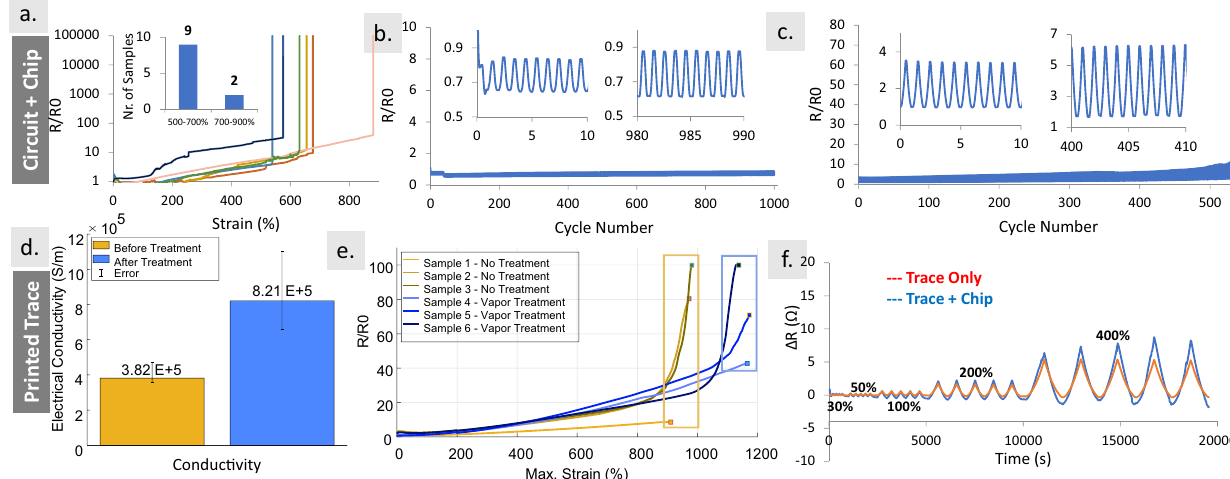
Fig. 2 Electromechanical characterization. a Max. strain tolerance of multiple samples with an integrated resistor package. b One hundred percent strain cycle of the chip-integrated sample. c Four hundred percent strain cycle of the chip-integrated sample. d Conductivity of printed traces before and after the Pol – Gel. e Maximum strain tolerance of the printed traces before and after the Pol – Gel. f Electrical resistance comparison of a printed trace without and with integrated chip, under strains of 30, 50, 100, 200, and